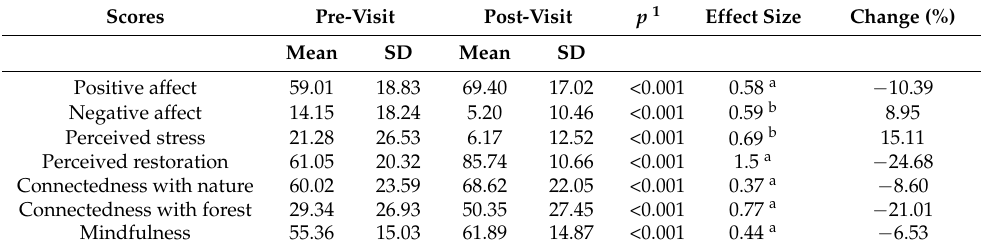
Table 2. Participants’ feelings and perceptions pre- and